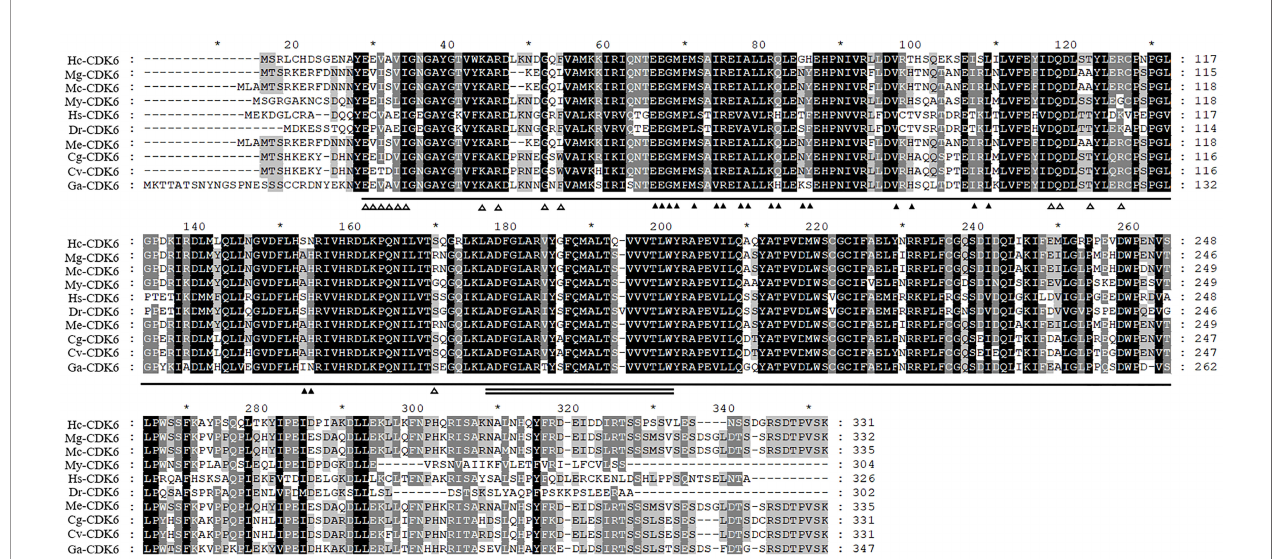
FIGURE 2 | Alignment analysis of Hc-CDK6 with homologous sequences in other species. ▲ Indicates the amino acid residue of CDK binding to CCND, △ indicates the amino acid residue of CDK binding to INK4, a horizontal line indicates the catalytic domain of cyclin-dependent kinase 4 and 6-like serine/threonine kinases of CDK6, and the double solid line indicates the activation loop (A-loop). GenBank accession numbers: Mytilus galloprovincialis (Mg), VDI04144.1; Mytilus coruscus (Mc), CAC5413630.1; Mizuhopecten yessoensis (My), XP_021356142.1; Homo sapiens (Hs), NP_001138778.1; Danio rerio (Dr), NP_001137525.1; Crassostrea gigas (Cg), XP_011426627.1; Crassostrea virginica (Cv), XP_022322423.1; Gigantopelta aegis (Ga), XP_041371365.1; Mytilus edulis (Me), CAG2221073.1. Black, conserved amino acid residue; gray, analogous residues. * Indicates that starting from the 10th amino acid, every 20 amino acids are marked with a *.